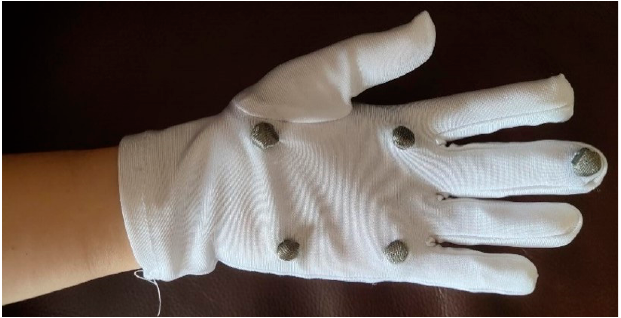
Figure 8. Manufactured glove with textile electrodes and a conductive strip.